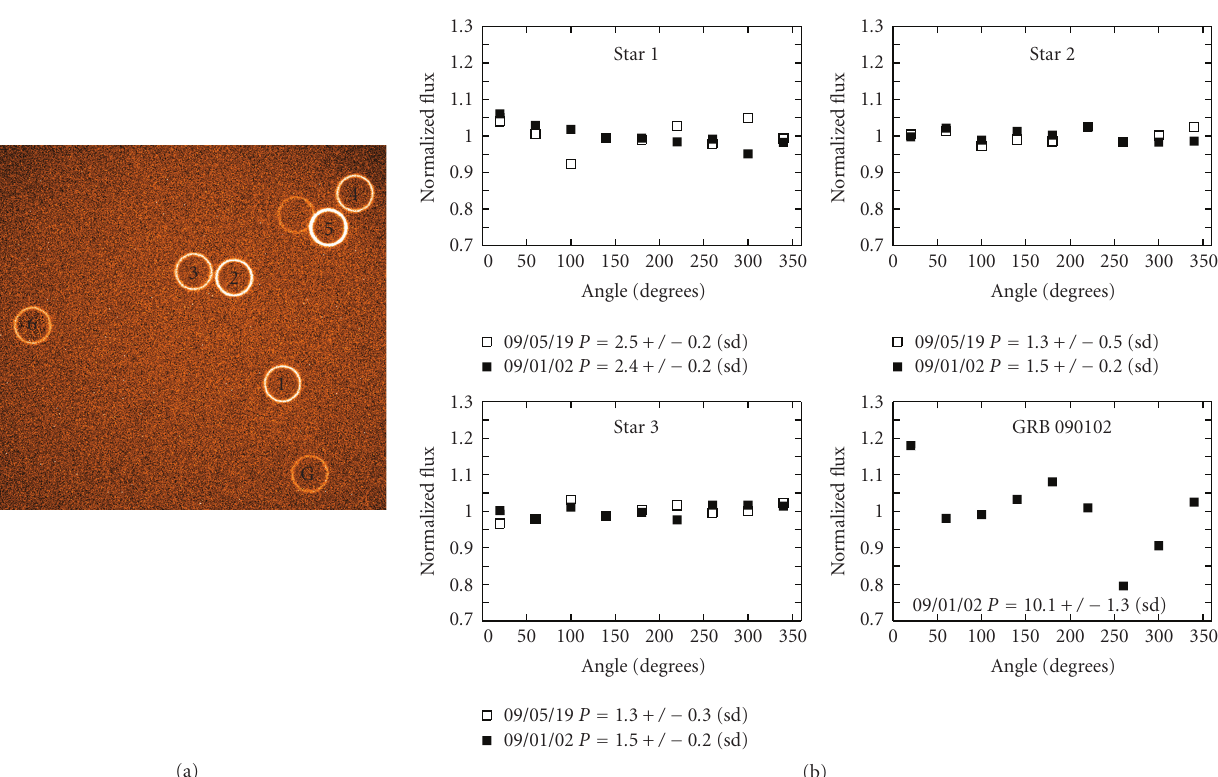
Figure 10: (a) RINGO image of field containing GRB 090102 (marked “G”); field stars are also visible. (b) Traces around rings for stars 1, 2, 3 and GRB 090102; derived polarisation % for each is quoted. [85].